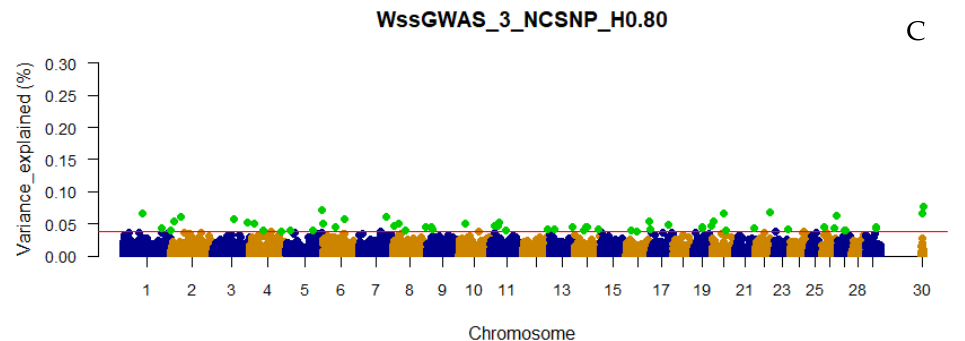
Figure 7. Manhattan plots of the percentage of the total additive genetic variance explained by non-clustered SNPs and haplotypes from haploblocks built with a linkage disequilibrium threshold of 0.80 for yearling temperament in American Angus cattle using single-step GWAS (ssGWAS_NCSNP_H0.80; A ) and weighted single-step GWAS in the second (WssGWAS_2_NCSNP_H0.80; B ) and third (WssGWAS_3_NCSNP_H0.80; C ) iterations. Green points highlighted above the red horizontal line are the top 0.001% markers that explained greater percentages of the total additive genetic variance for YT. The X-chromosome (PAR region) is represented by the chromosome 30.